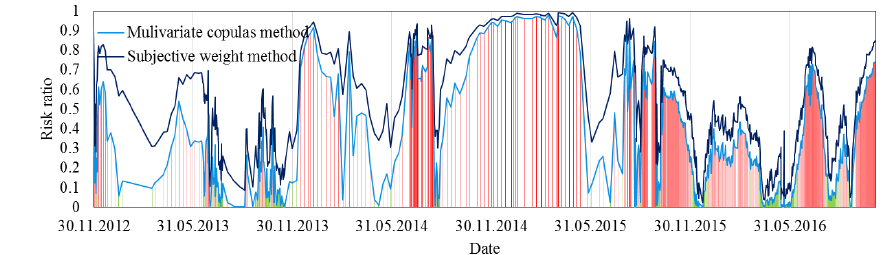
Figure 18. Multi-point risk ratios for dam Section 9# of the Jinping-I arch